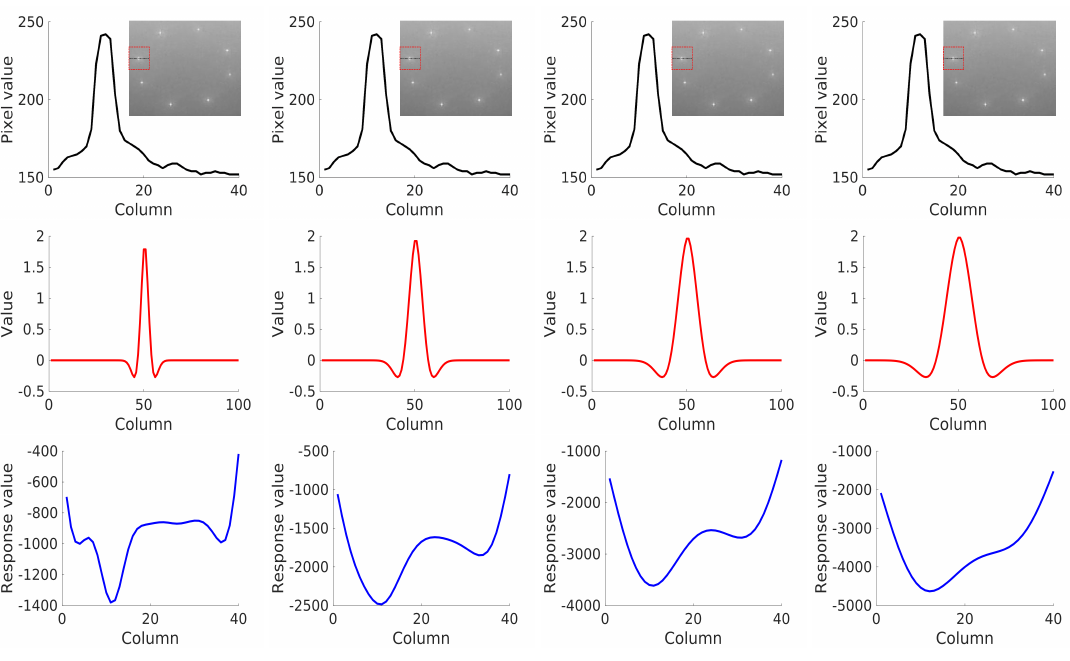
Figure 3. (First row) 1D pixel values along the black dotted line in the red bounding box. (Second row) Negatives of the Laplacian-of-Gaussian (LoG filters) with σ = 3, σ = 5, σ = 7, and σ = 9, from left to right. (Third row) Corresponding results obtained by convolving the original signal in the first row with the filter in the second